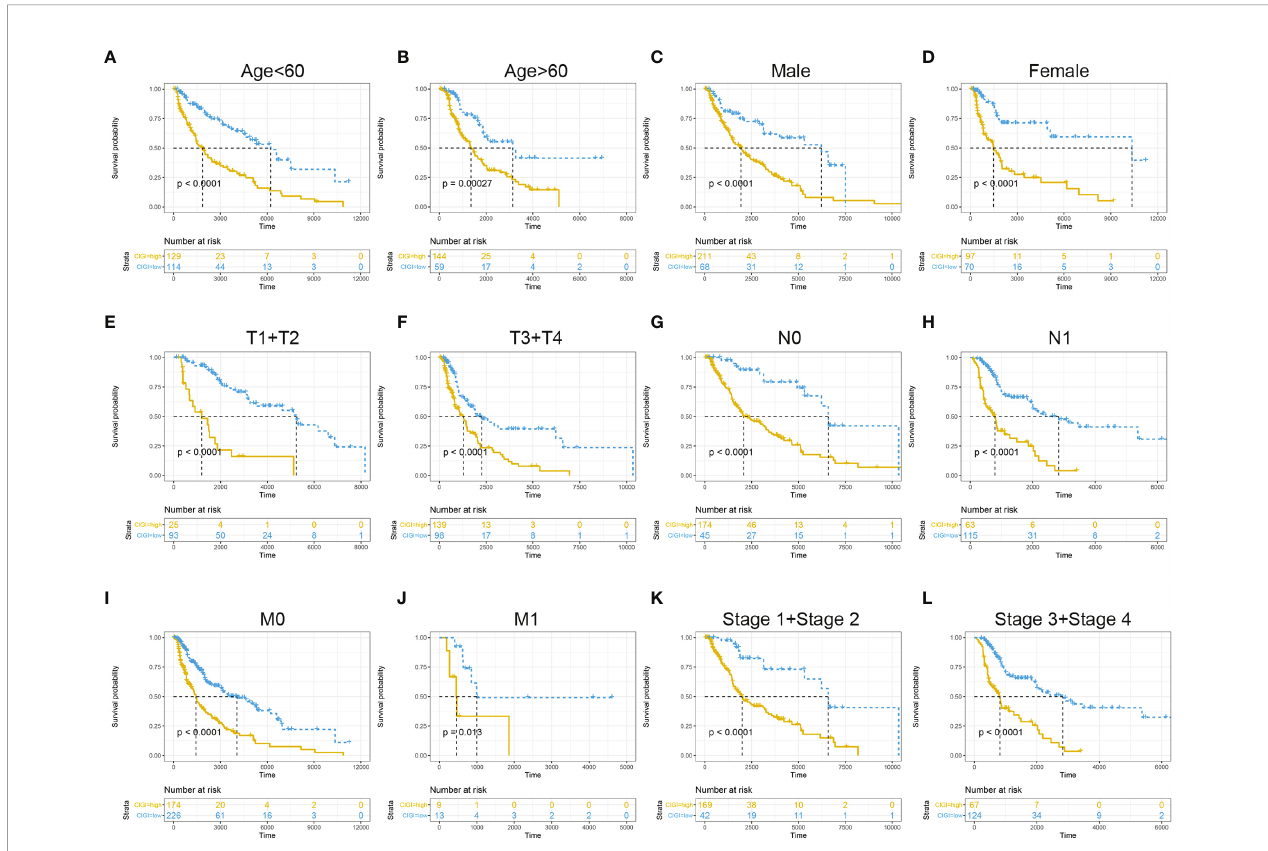
FIGURE 4 | Prognostic signi fi cance of CIGI in melanoma patients with different clinical features. (A) Age < 60, (B) Age > 60, (C) Male (D) Female (E) T1+T2 (F) T3+T4 (G) N0 (H) N1 (I) M0 (J) M1 (K) Stage 1+ Stage 2 (L) Stage 3+ Stage